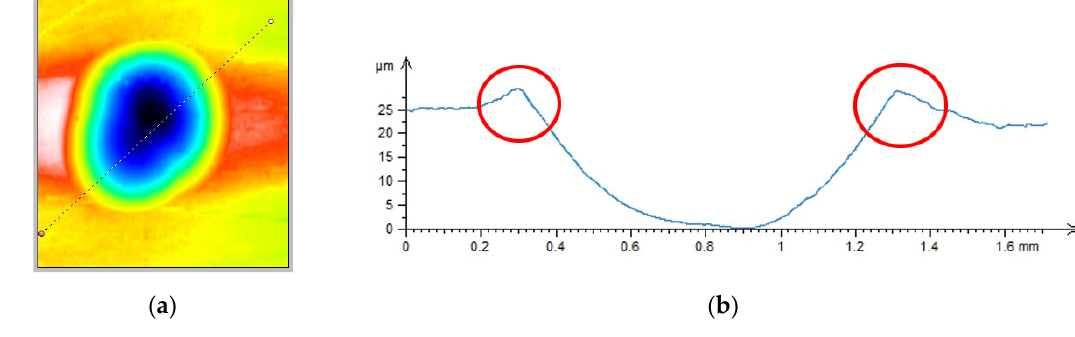
Figure 5. Dimple after impact: ( a ) dimple topography, ( b ) cross-section.